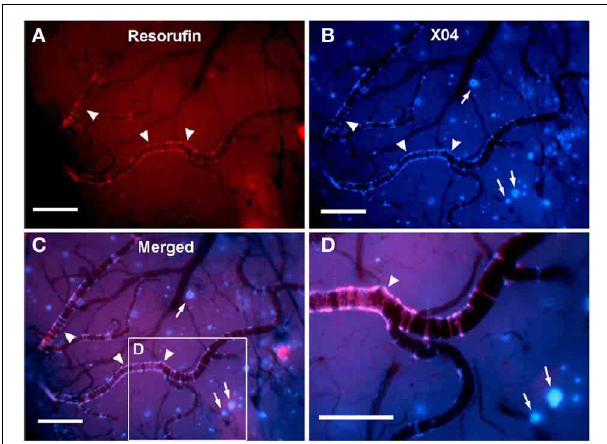
FIGURE 2 | In vivo live imaging of CAA amyloid deposits through cranial window. Closed cranial windows were prepared on the right parietal bone of 16-month-old Tg2576 mice and the congophilic amyloid binding dye, methoxy-X04 (X04), was administered (6mg/kg i.p.). On the next day, 2 μ M resorufin (dissolved in artificial CSF) was superfused over the brain through a closed cranial window for 5min. After washing with artificial CSF for 10min, live fluorescent images of resorufin (red) and X04 (blue) were taken. (A) Intense fluorescent labeling detected within the walls of the leptomeningeal arteries (arrowheads) but not in neuritic plaques after topical application of resorufin. (B) In contrast, topical application of methoxy-X04 labeled A β aggregates in both cerebral arteries (arrowheads) and parenchymal neuritic plaques (arrows). (C) Resorufin- and X04-images merged. (D) Magnified detail of (C) . Scale bars: 100 μ m. Reproduced with permission from Han et al. (2011), © 2011 Han et